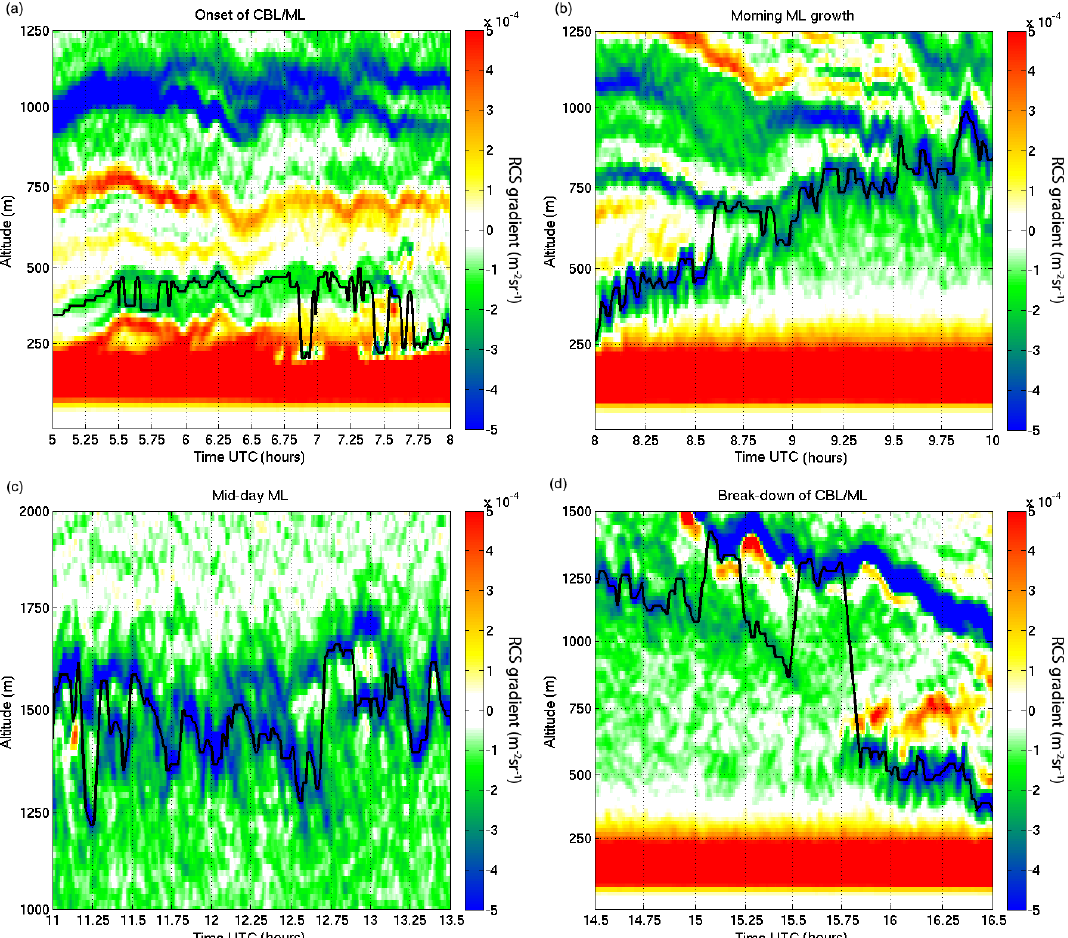
Figure 4. Highlights of the MLH evolution at Cabauw on 20 May 2010. See text in Sect. 4.1. Gradients in RCS and pathfinder MLH estimates during a clear-sky day. These include (a) the period between sunrise and onset of the ML, (b) the morning growth of the ML, (c) the midday structure of the MLH and (d) the break-down of the ML. Time is indicated in decimal